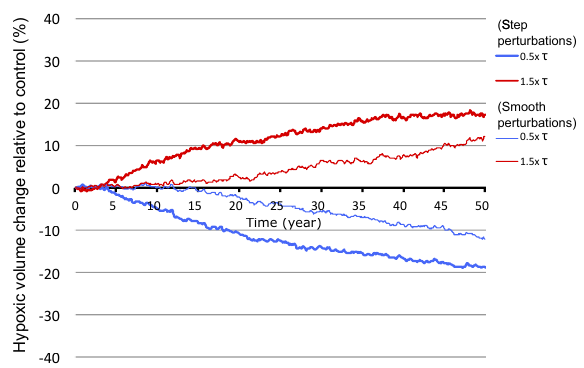
Figure A11. OMZ response to gradual vs. abrupt wind changes. Changes in hypoxic volume (in %) under gradually increasing or decreasing winds (thin lines) and instantly increased or decreased winds (thick lines). The smooth wind perturbation corresponds to an increase or decrease of wind stress at a rate of 1%yr − 1 over the 50-year duration of the simulation. The abrupt wind perturba- tion corresponds to an instant increase or decrease of wind stress by